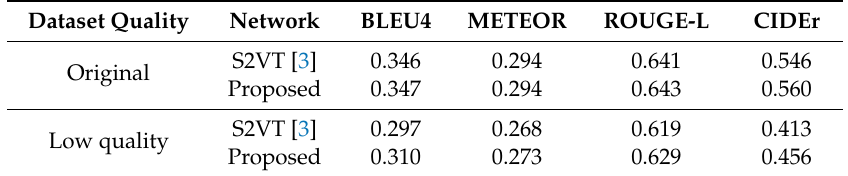
Table 1. Description performance of the proposed network (Figure 5), when the original MSVD dataset and its low quality dataset were used for the network training.